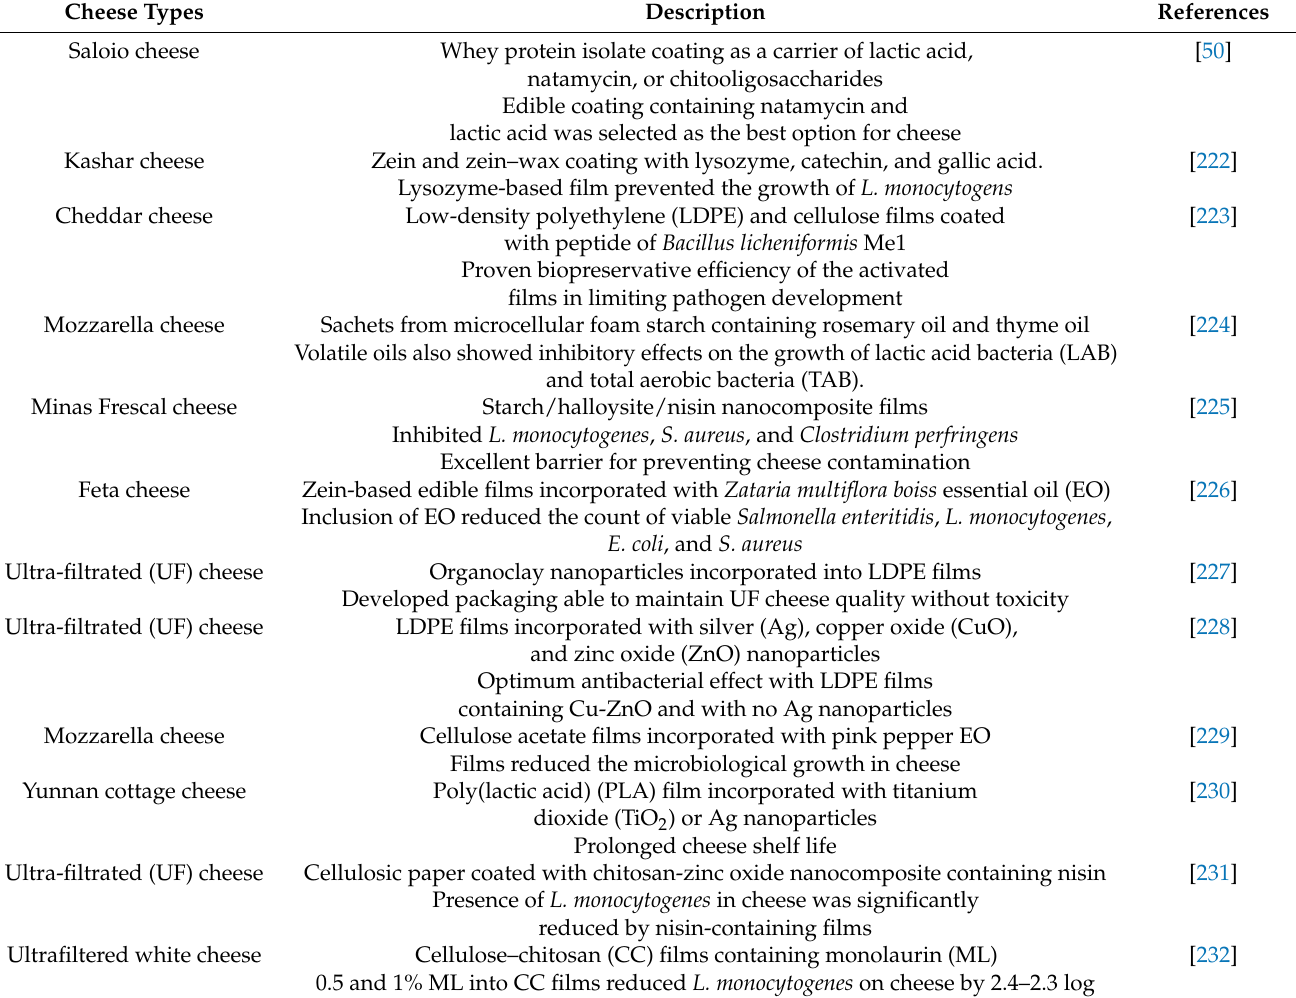
Table 6. Examples of antimicrobial packaging applicable to